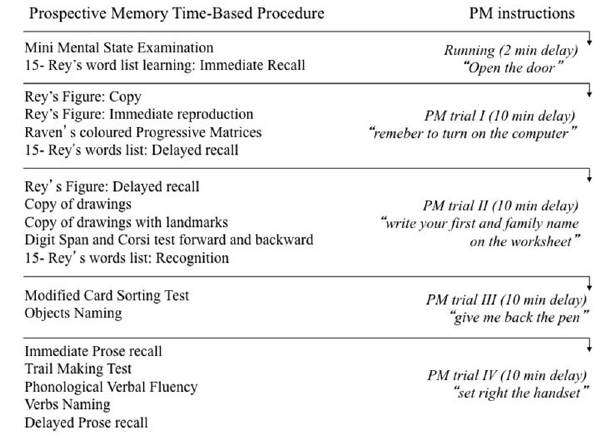
FIGURE 1 | The Figure illustrates the order of administration of the neuropsychological screening tests during the administration of the prospective memory procedure